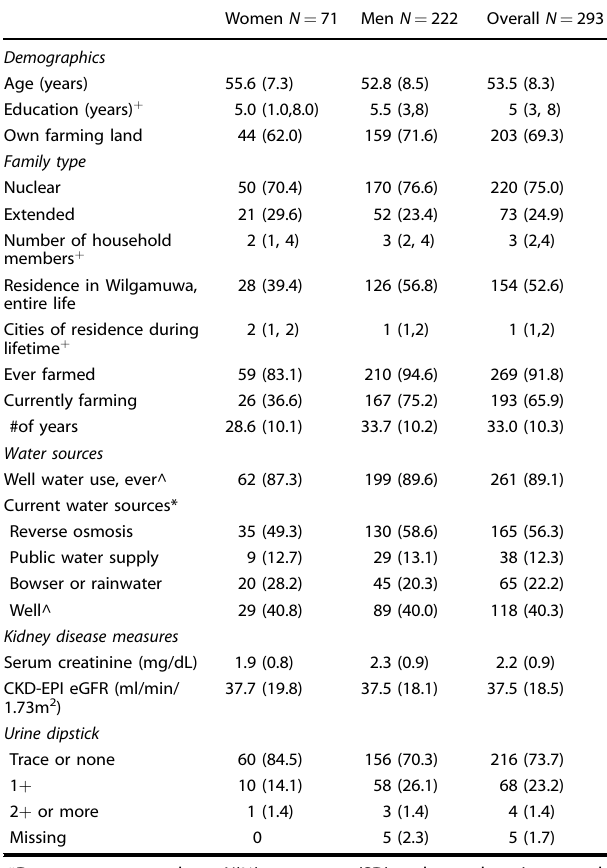
Table 1. General characteristics of participants in study cohort at baseline (Sept – Dec 2017) # .